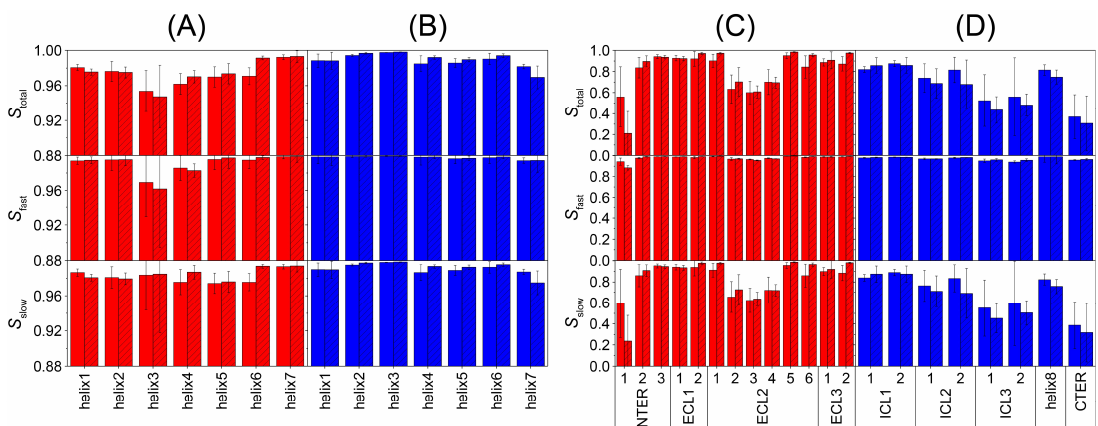
Figure 7. Order parameters of the individual segments of Y1R calculated from the MD simulations. The top row shows the total order parameter S total of each segment, whereas the two lower panels show the individual contributions from fast ( S fast ) and slow ( S slow ) motions. Open bars correspond to the apo state, whereas striped bars correspond to the antagonist-bound state. Panel ( A ) corresponds to the extracellular helix segments, whereas ( B ) shows their intracellular counterparts. Panels ( C , D ) show the loops, termini, and Helix 8, also grouped into extracellular and intracellular segments, respectively. In all panels, the arithmetic mean over all three runs is shown with error bars corresponding to the standard deviation. Note the di ff erence in the range of order parameters between helices ( A , B ) and loops, termini, and Helix 8 ( C , D